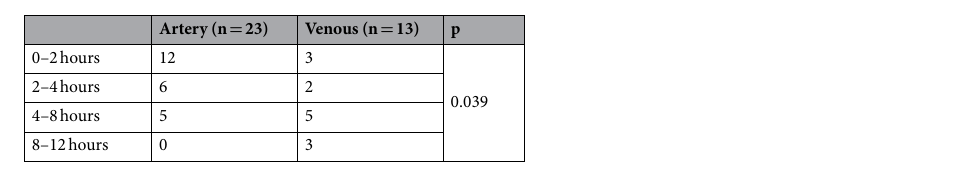
Table 2. Compare of different time of the first sign of artery or venous